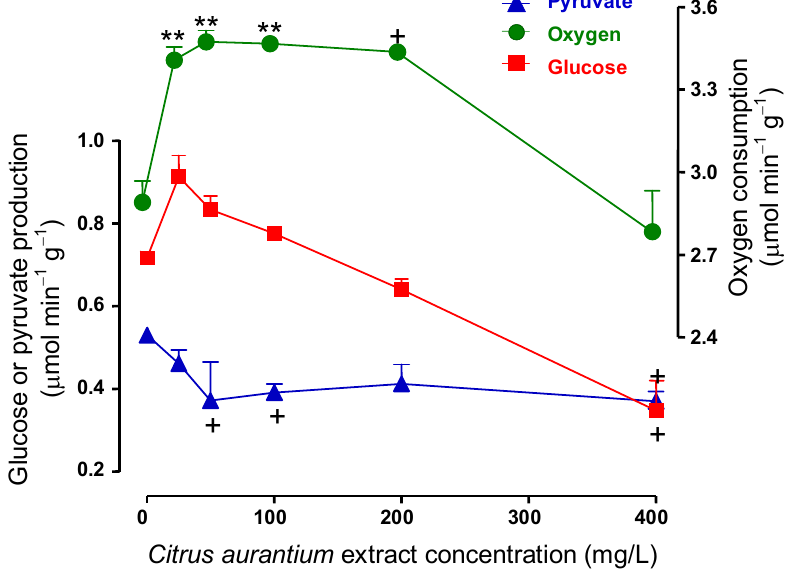
Figure 6. Effects of the C. aurantium extract on gluconeogenesis and related parameters: concentration dependences. The experimental protocol was the same illustrated by Figure